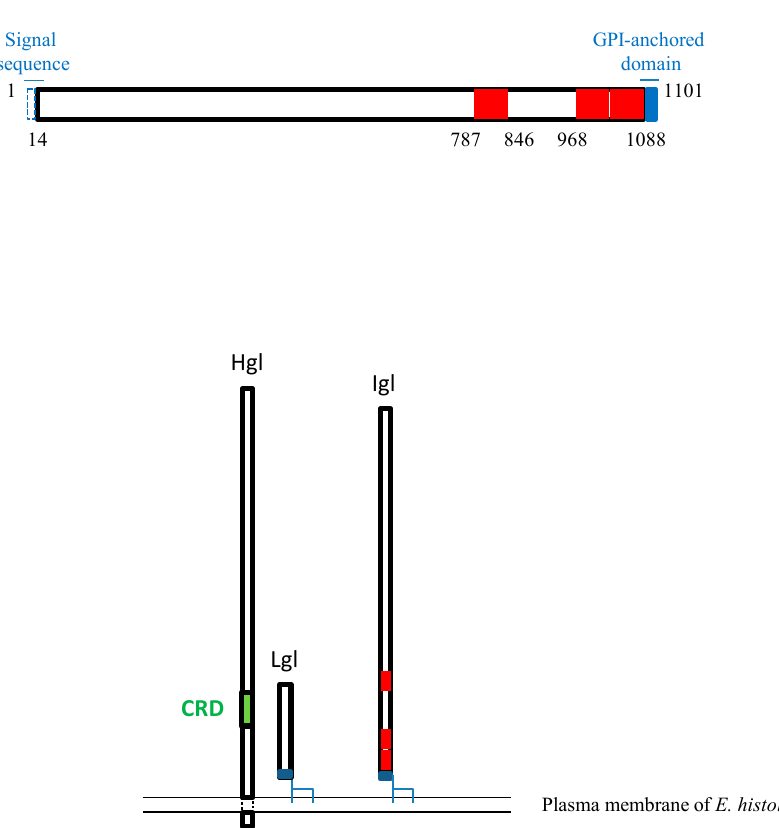
Figure 5. Hemolytic and cytotoxic regions of Igl1. ( A ) The Igl1 14-1088 recombinant fragment lacks the signal sequence (aa 1–13) and GPI-anchored domain (aa 1089–1101). Regions in red are those with both hemolytic and cytotoxic activities. ( B ) Schematic of Hgl, Lgl and Igl on the cell membrane of E. histolytica . Igl is associated with other lectin subunits: Hgl and Lgl. CRD: carbohydrate recognition domain.